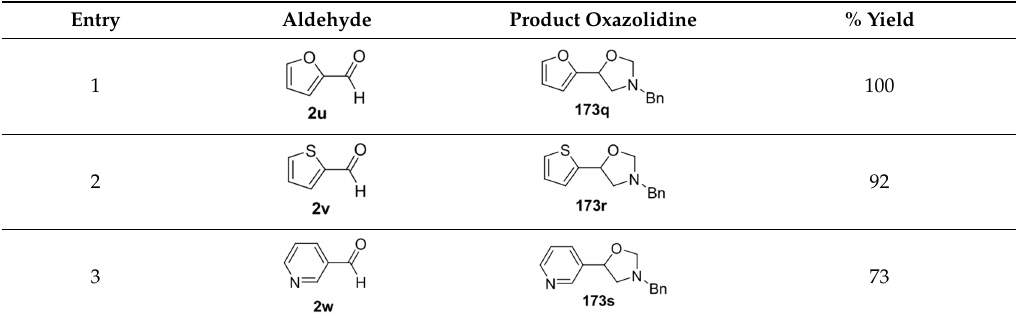
Figure 2. The bis adduct isolated from the reaction of 4-hydroxybenzaldehyde ( 2t , Table 23, entry 16). The cycloaddition of ylide 172 , generated by trifluoroacetic acid catalyzed decomposition of silylamine reagent 178 , to a range of heteroaromatic aldehydes 2 was also explored with the only limitation appearing to be electron-rich aromatic aldehydes (Table 24) [133]. 2-Furan-, 2-thiophene- and 3-pyridine carboxaldehydes ( 2u – w ) all underwent efficient cycloaddition under these conditions (Entries 1–3). In contrast, experiments with pyrrole-2-carboxaldehyde ( 2x ) and N -methylpyrrole-2- carboxaldehyde ( 2y ) afforded complex intractable product mixtures with no sign of oxazolidine products (Entries 4 and 5). The lack of effective cycloaddition under these conditions was thought to be due to the electron-rich nature of the pyrrole leading to deactivation of the pyrrole via increasing the carbonyl LUMO energy with concomitant increase in the carbonyl LUMO-azomethine ylide HOMO energy gap. Consistent with this rationale, when the pyrrole contained the electron-withdrawing Table 24. Cycloaddition of azomethine ylide 172 , formed from silylamine reagent 178 , with heteroaromatic aldehydes 2 (Scheme 45). Entry Aldehyde